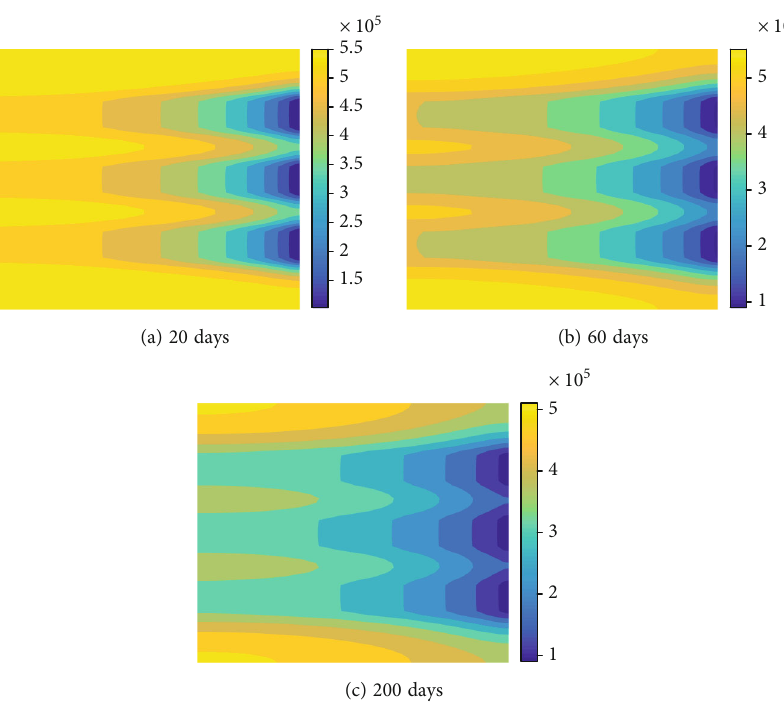
= 20 mol/m 3 at di ff erent times. b